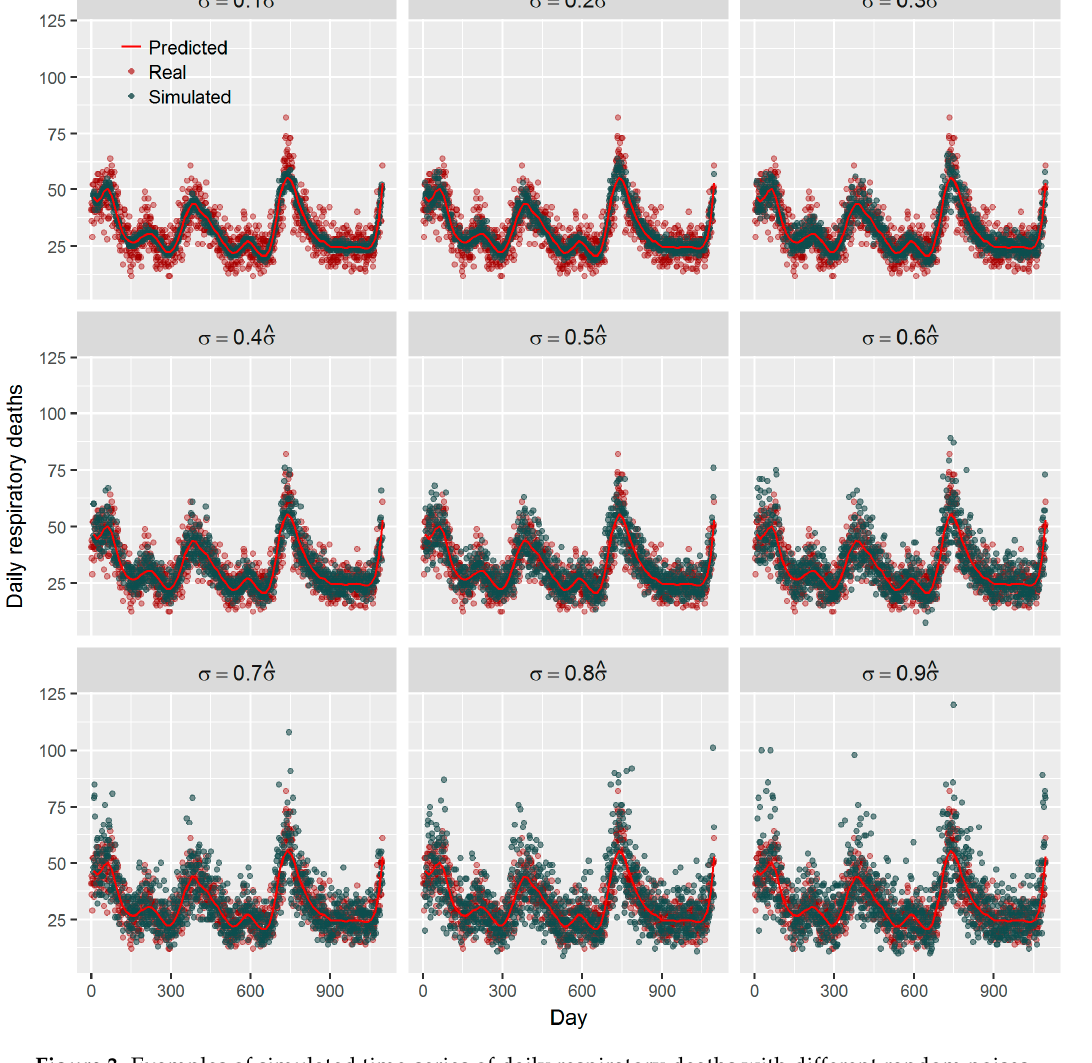
Figure 3. Examples of simulated time-series of daily respiratory deaths with different random noises.